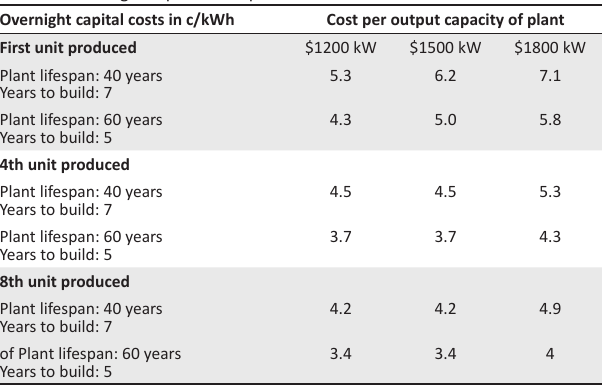
TABLE 2: Overnight capital cost options.